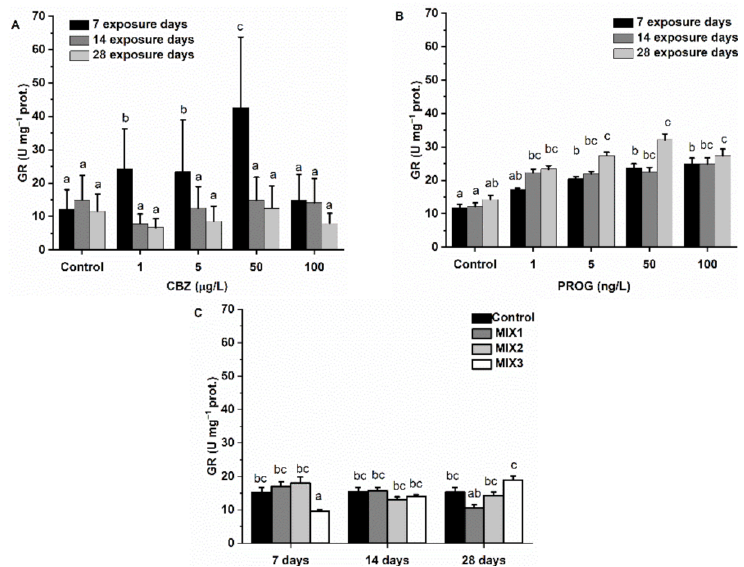
Figure 6. Changes in GR activity in the liver of Danio rerio exposed to ( A ) CBZ, ( B ) P4, and ( C ) binary mixtures of CBZ and P4 for 7, 14, and 28 days. Data are expressed as mean ± standard deviation of fifteen replicates ( n = 15). Different letters show significant differences at p < 0.05 after a two-way ANOVA followed by Tukey’s post hoc test.